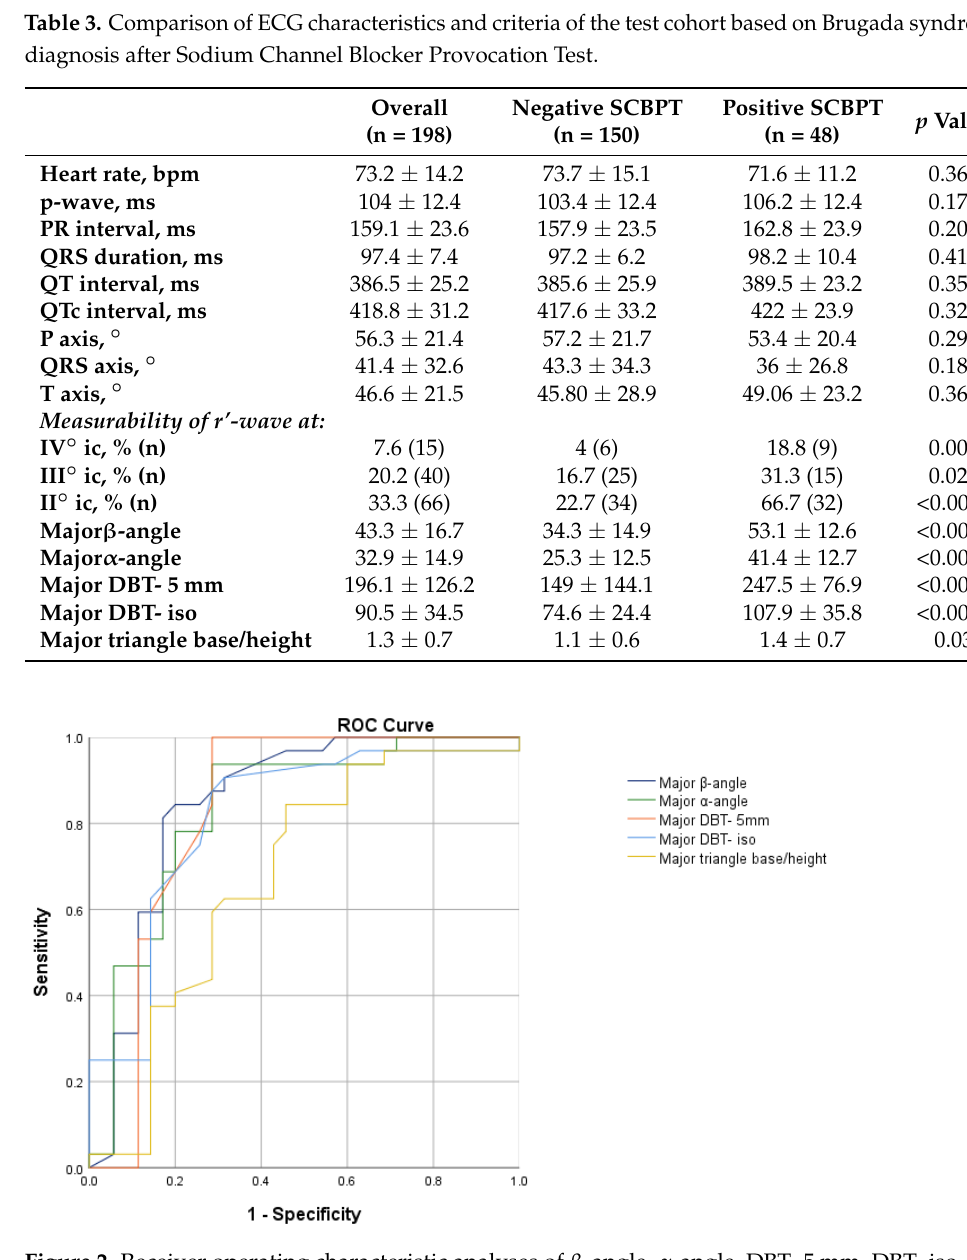
Figure 3. r’-wave algorithm illustration.